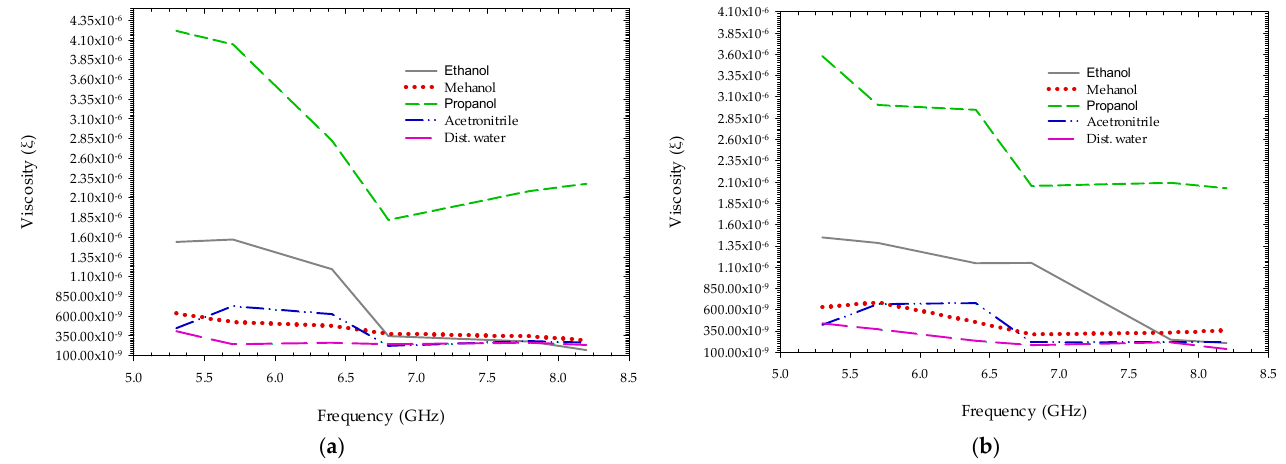
Figure 14. Resistivity experienced by a wave at different transmitting impulse frequencies through MUT using ( a ) podal antenna; ( b ) antipodal antenna. MUT using ( a ) podal antenna; ( b ) antipodal